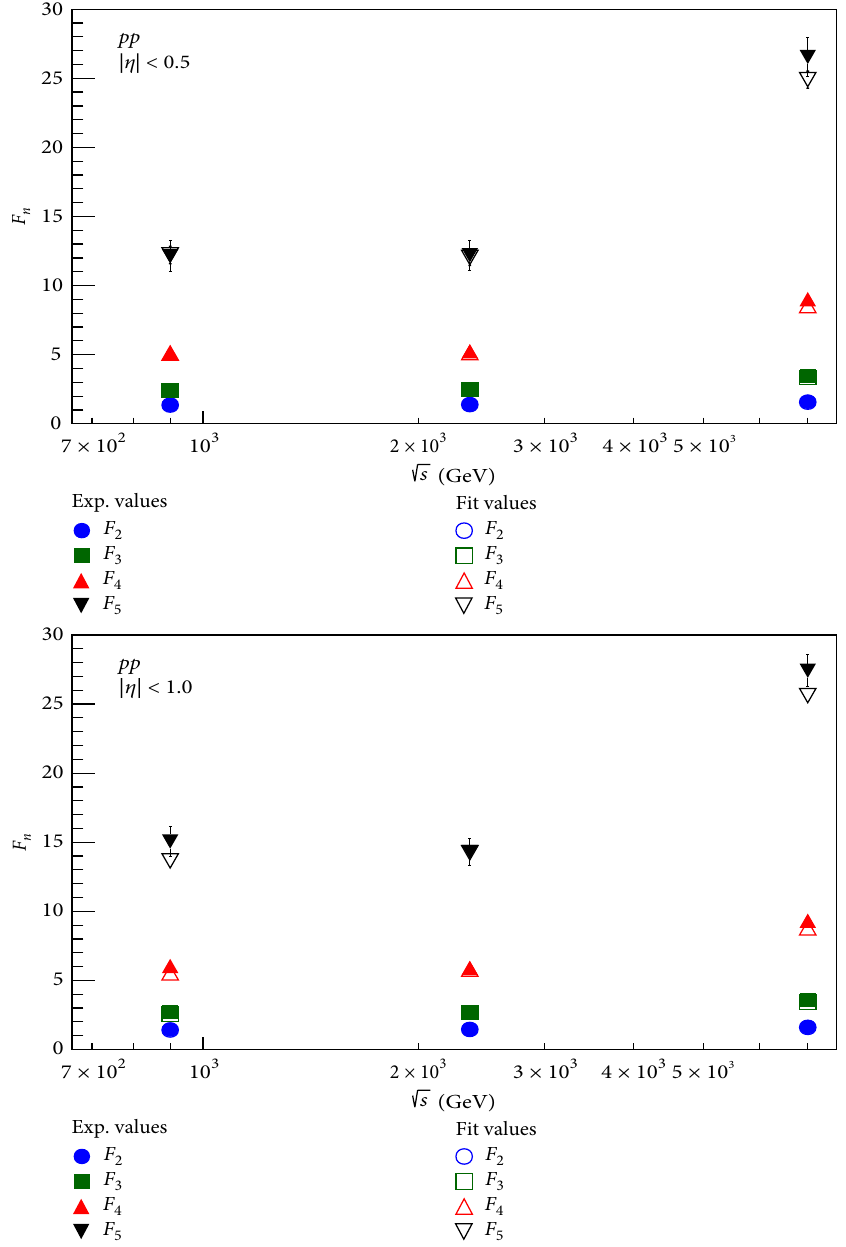
of modified shifted Gompertz distribution for the n